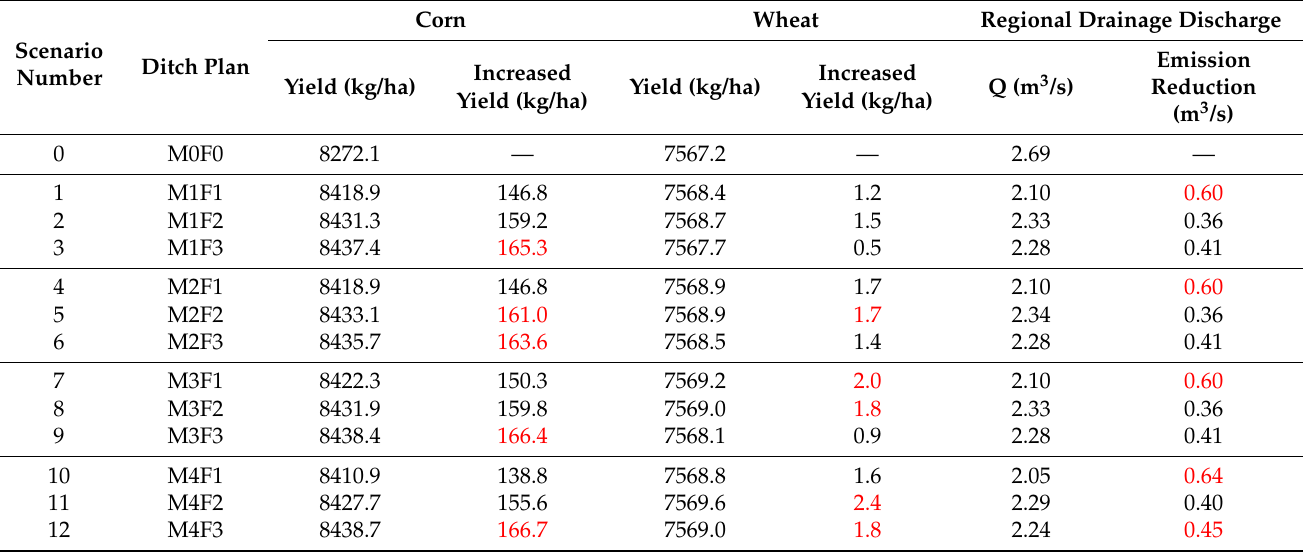
Table 4. Comparison of crop yield and regional drainage discharge with the current situation under the combined control